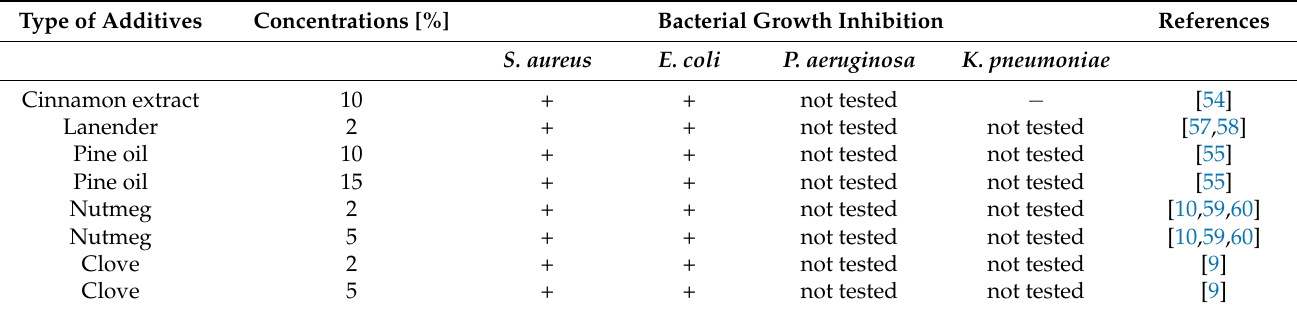
Table 10. Methods of polyurethane foams modification to obtain antibacterial properties of the material. Type of